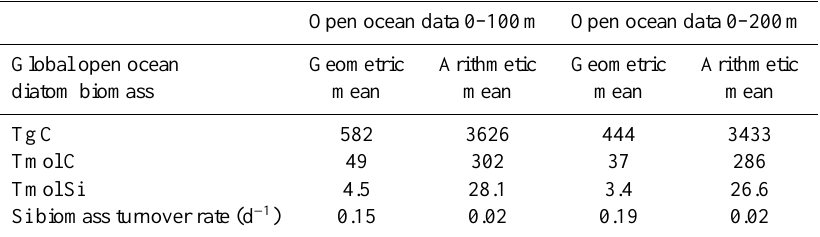
Table 5. Global open ocean budget of diatom biomass for the dataset without coastal sites (where bathymetry < 100m) expressed in TgC, TmolC and TmolSi, and Si biomass turnover rate estimates in d − 1 (see discussion section for calculation